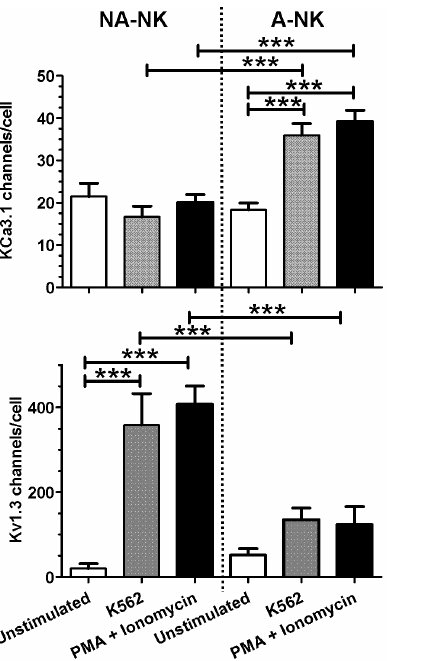
Figure 2. Activation induces an up-regulation of Kv1.3 by NA- NK cells and of KCa3.1 by A-NK cells. Cells were patch-clamped in the whole-cell configuration without stimulation and after stimulation with either an equal number of K562 cells or 40 ng/ml PMA + 500 nM ionomycin for 24 hours and numbers of KCa3.1 ( top ) and Kv1.3 ( bottom ) channels were calculated. Each bar represents the mean 6 SEM channel numbers. Cells from a minimum of 3 donors were used for each condition and a minimum of 10 cells were analyzed for each donor.